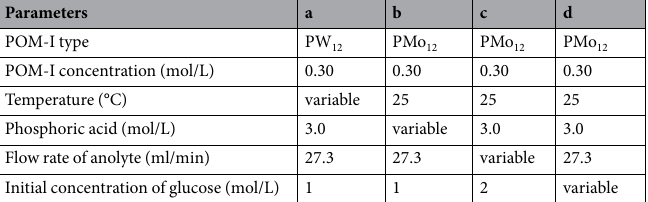
Table 1. Operational conditions of the LCFC for the four groups of tests.